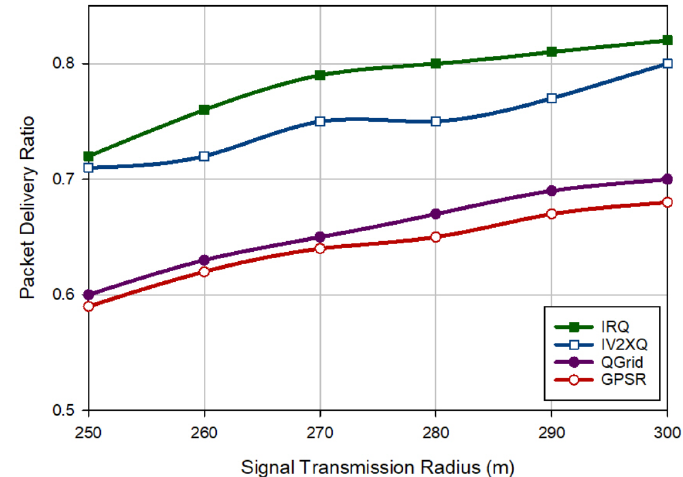
Figure 5. Comparison of PDR in different routing methods based on